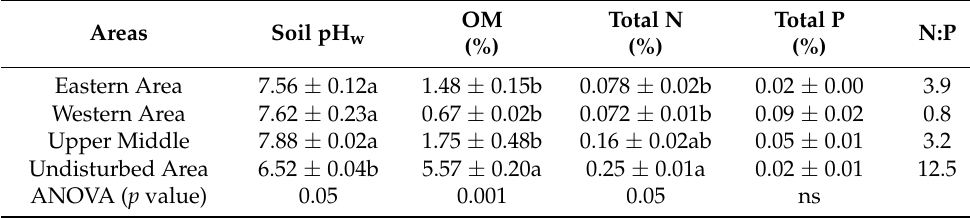
Table 1. Selected background soil data of the study area.